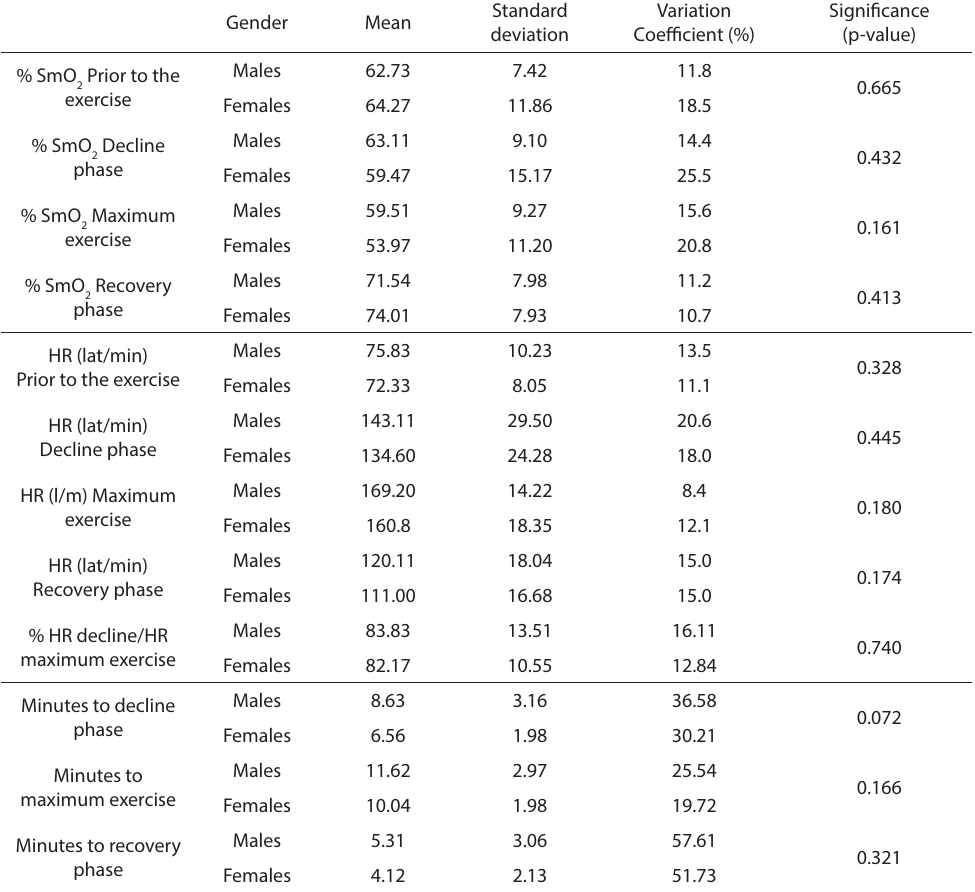
TABLE 2. Comparison, between genders (males n=18; females n=12), of SmO